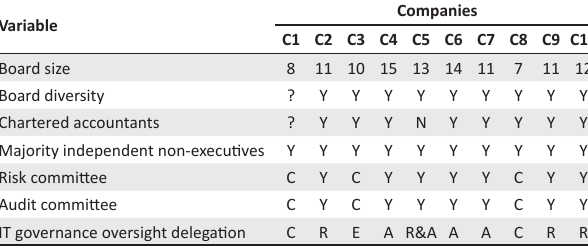
TABLE 1: Board structure of participating